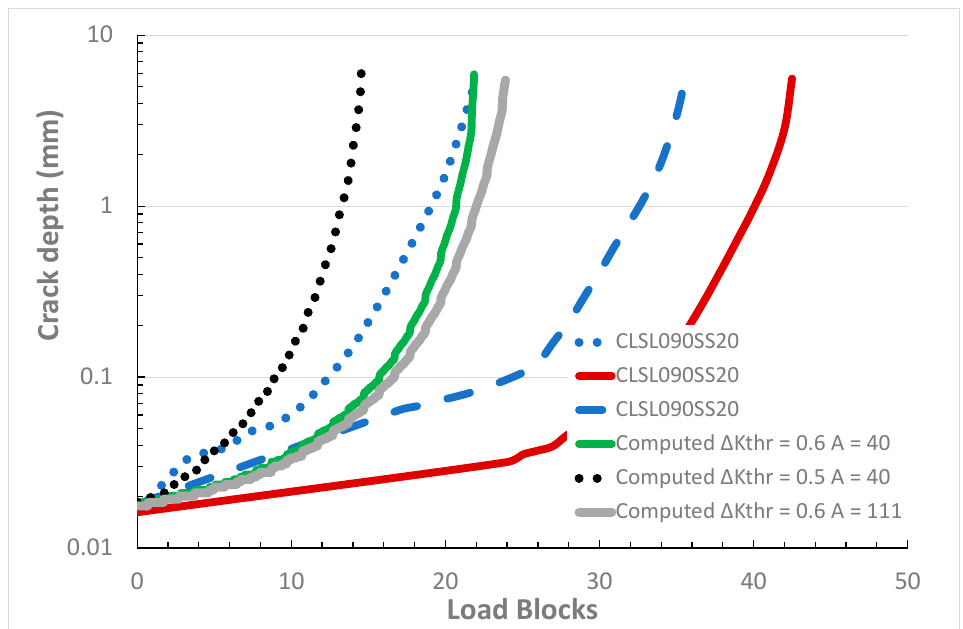
Figure 12. The measured and computed crack depth histories for the helicopter flight load spectrum CLS0900SS20.